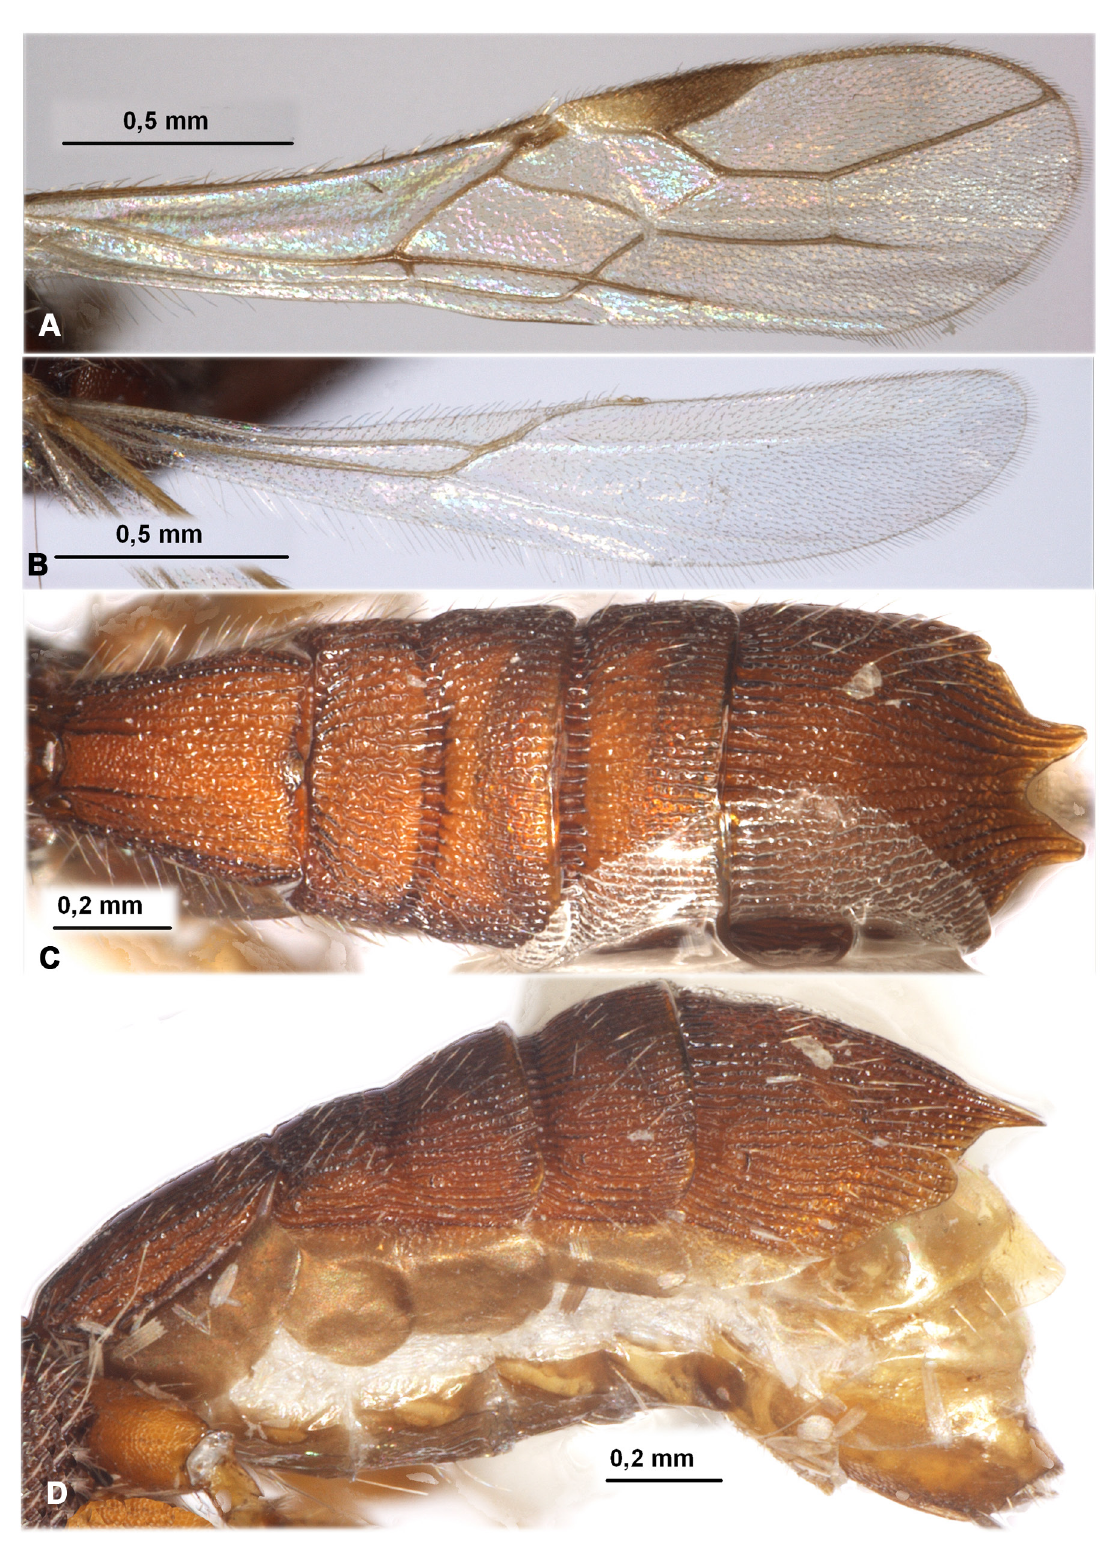
Fig. 62. Rhaconotus ( Rh. ) vanharteni Belokobylskij sp. nov., holotype, ♀ (RMNH). A . Fore wing. B . Hind wing. C . Metasoma, dorsal view. D . Metasoma, lateral